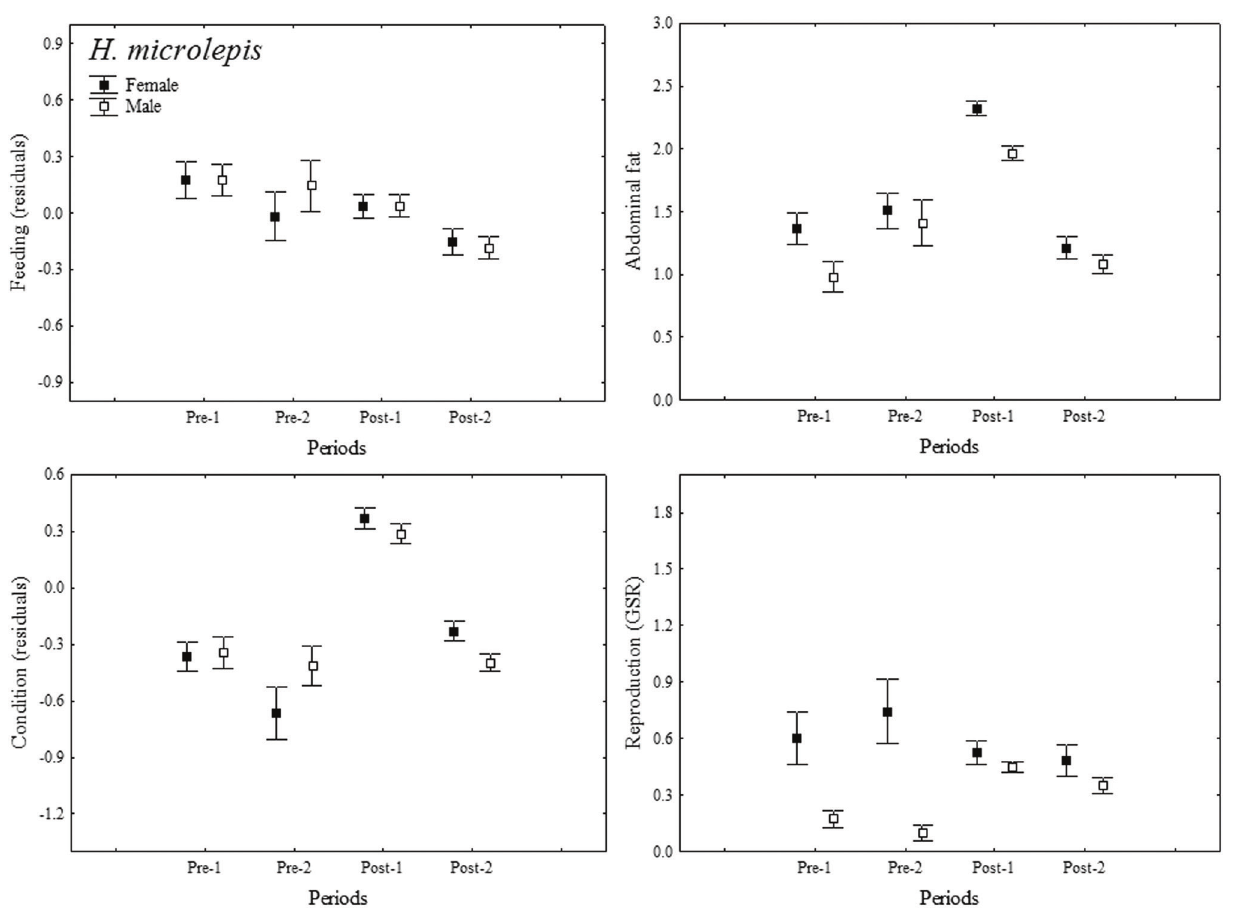
Fig. 3. Variation in feeding activity (standard residuals, regression between LS x WS), visceral fat storage, body condition (standard residuals, regression between LS x TW) and reproductive effort (GSR) of Hemiodus microlepis , before (Pre-1 and 2) and after (Post-1 and 2) the construction of Lajeado